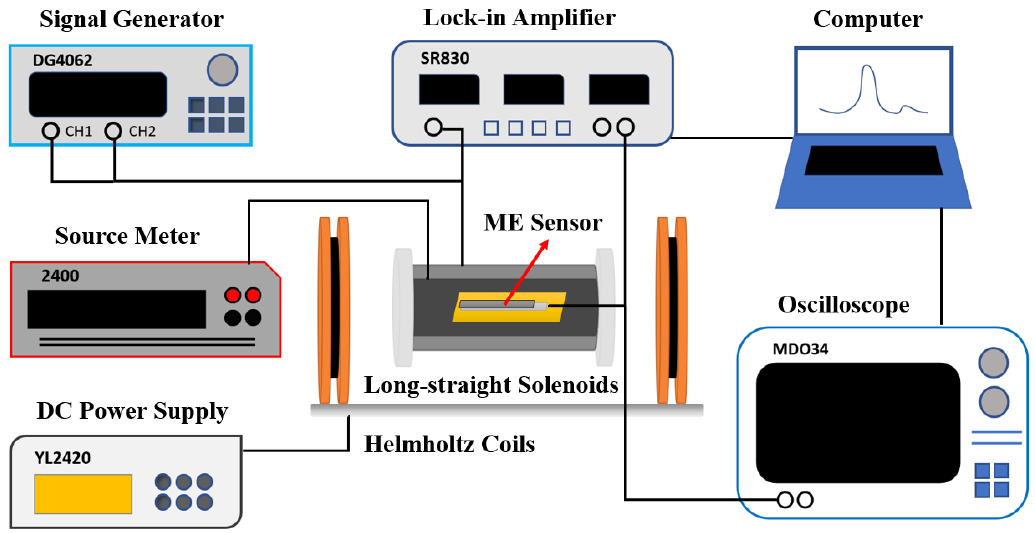
Figure 1. Schematic showing the principle of the ME test system (the actual wiring method can be adjusted according to the test types).